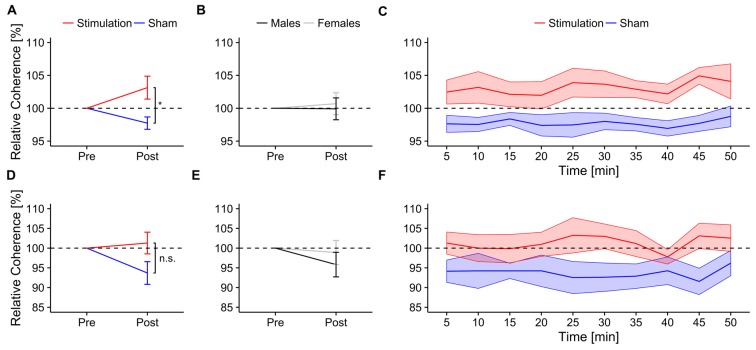
Ongoing alpha coherence. Ongoing normalized alpha coherence during mental rotation. Top row: normalized coherence between electrode P3 and P4. Error bars and shaded areas depict SEM; asterisks code for significant differences (*<0.05). (A) Averaged normalized coherence after stimulation for stimulation and sham. (B) Averaged normalized coherence after stimulation for females and males. (C) Time-course of normalized coherence after stimulation for stimulation and sham group. Bottom row: normalized coherence between electrode P7 and P8. (D) Averaged normalized coherence after stimulation for stimulation and sham. (E) Averaged normalized coherence after stimulation for females and males. (F) Time-course of normalized coherence after stimulation for stimulation and sham group.